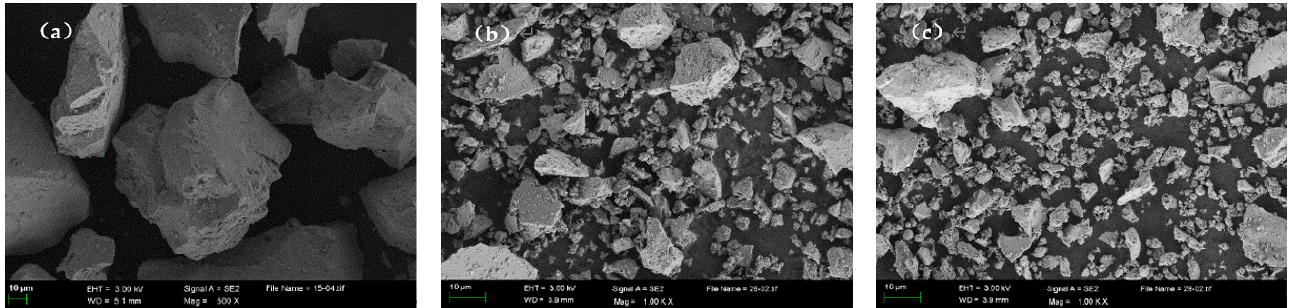
Figure 2. SEM images of ( a ) IOTs, ( b )PS, and ( c )SS.